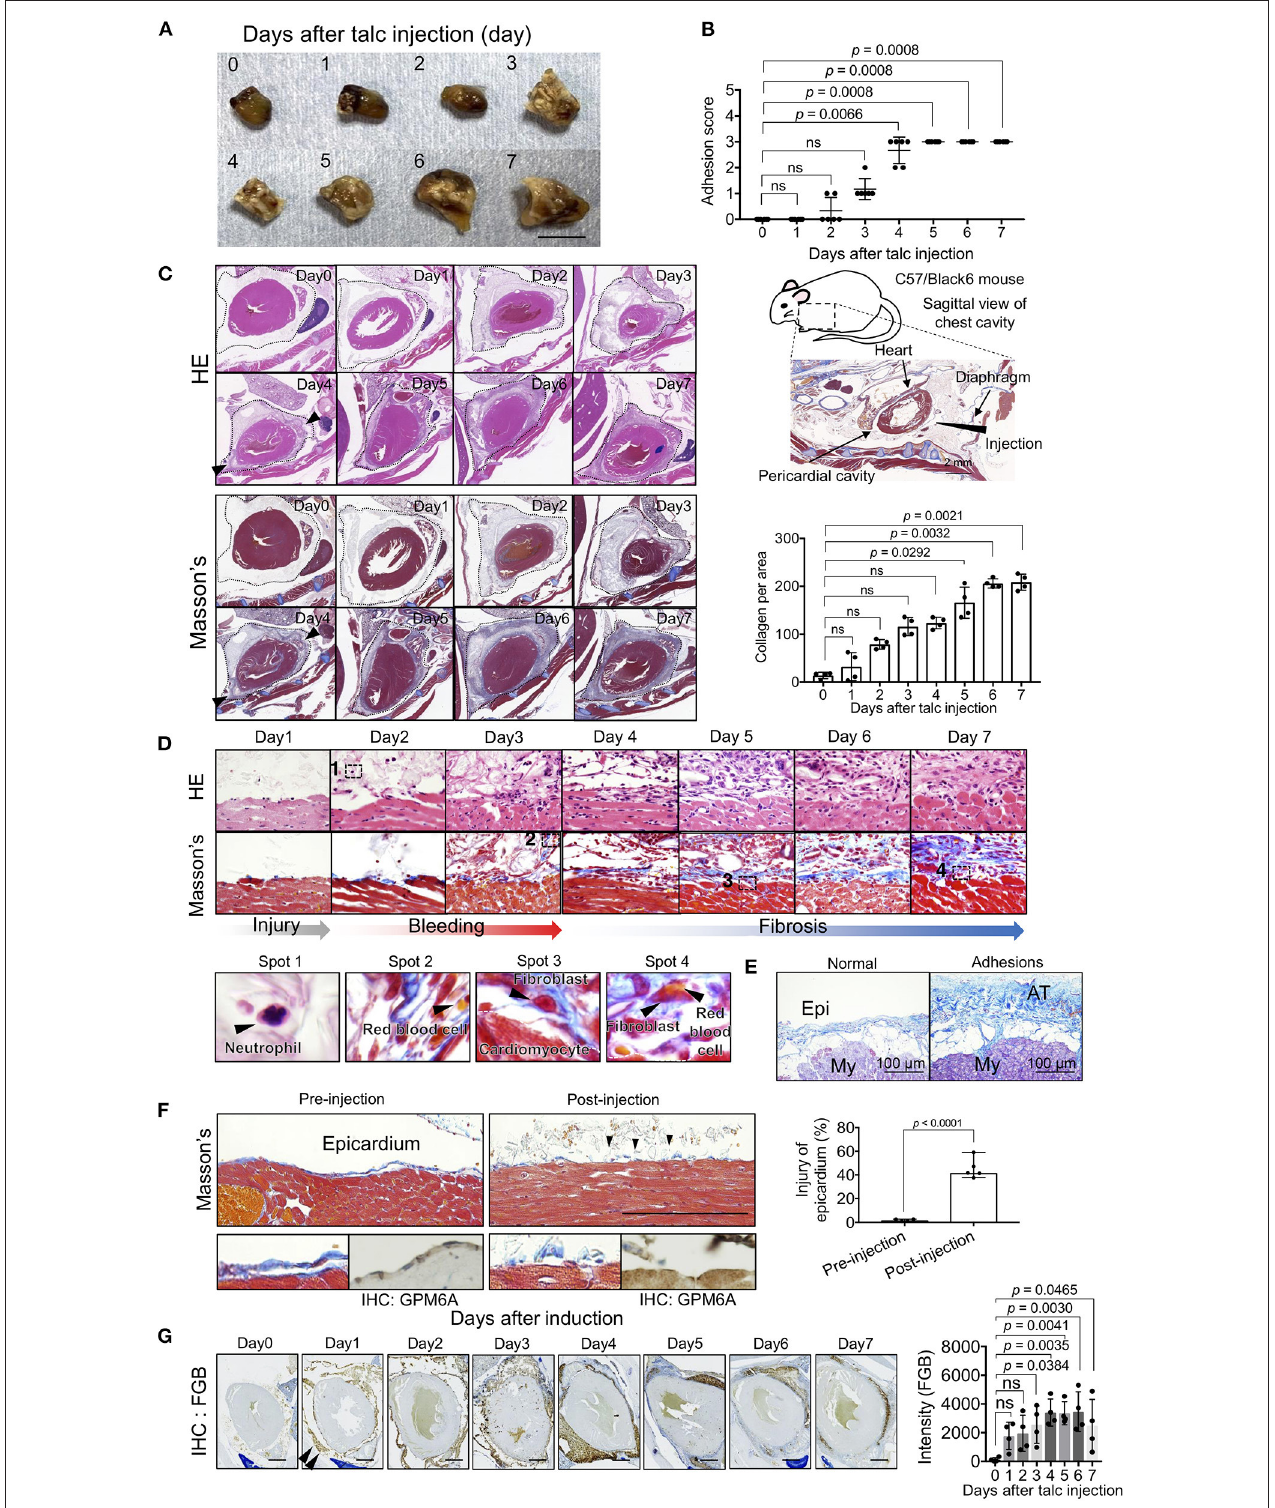
FIGURE 1 | Spatiotemporal evaluation of pericardial adhesion formation. (A) Excised hearts within 7 days of adhesion induction (talc injection). Bar = 8mm. (B) Adhesion scores of the excised heart tissues ( n = 6). Data are presented as means ± SE. Statistical analyses were performed using Kruskal-Wallis test with Dunn’s multiple comparison test (non-parametric variables). (C) H and E (left upper) and Masson’s trichrome (left lower) staining of the sagittal sections of the chest cavity